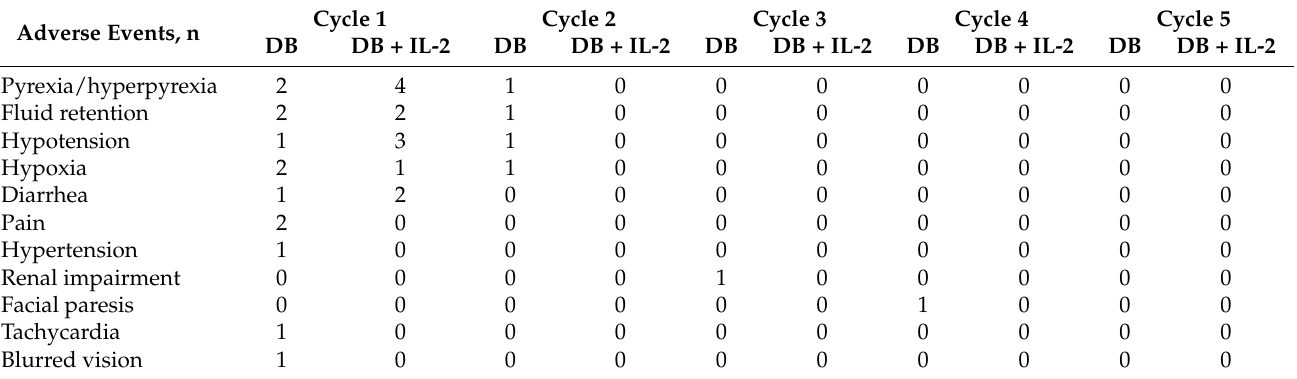
Table 4. Grade 3/4 adverse events occurring during each cycle of dinutuximab beta therapy in patients treated with or without